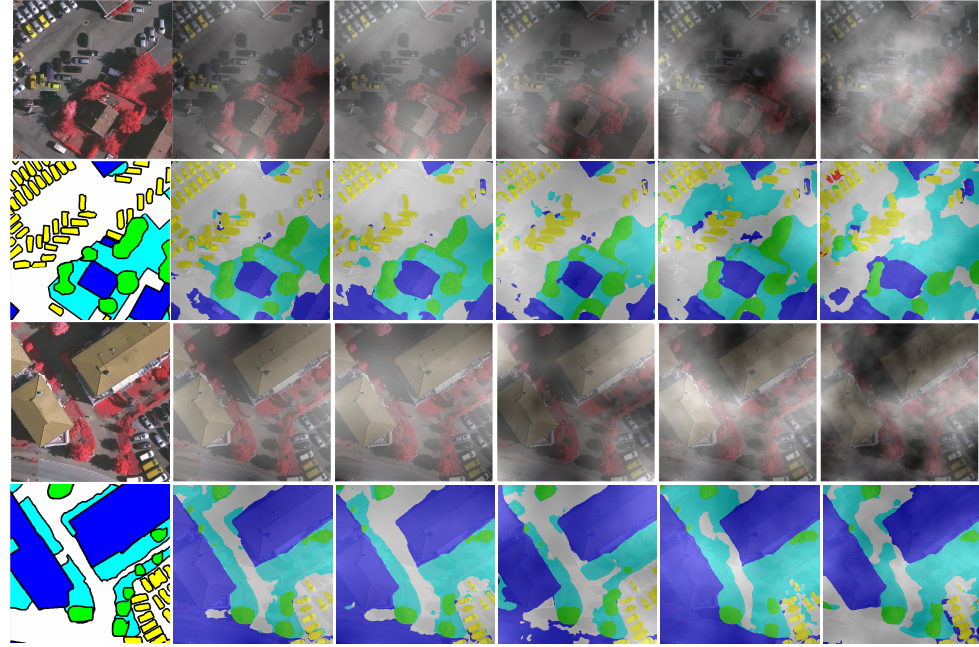
Figure 9. Comparing the LCC results across different corruption levels. 1st column displays the clean image and ground truth. Others are images with fog of various severity levels, accompanied by the corresponding semantic labeling result. From left to right, the fog intensity increases